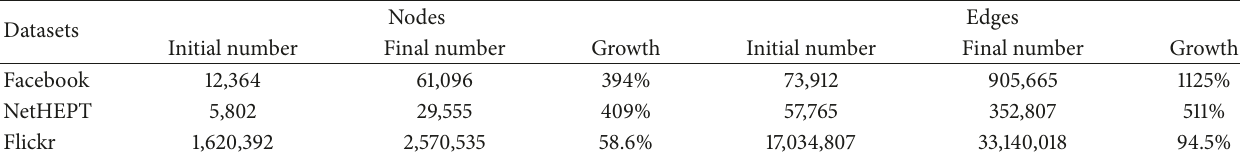
Table 2: Summary information of the real-world social